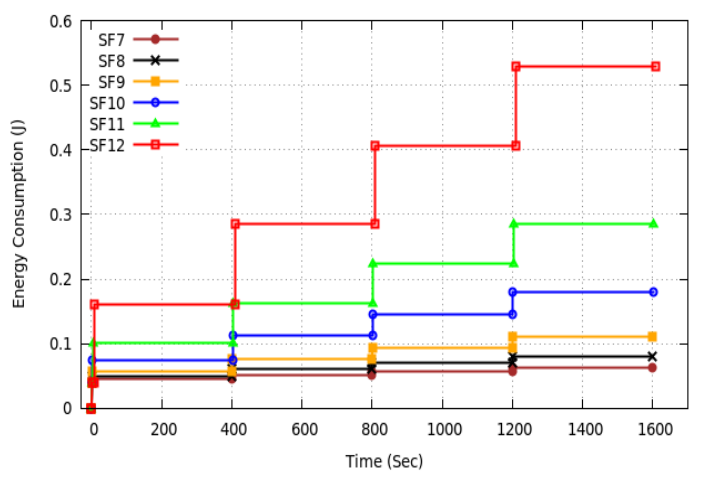
Figure 13. ED Energy Consumption during a Synchronization period.